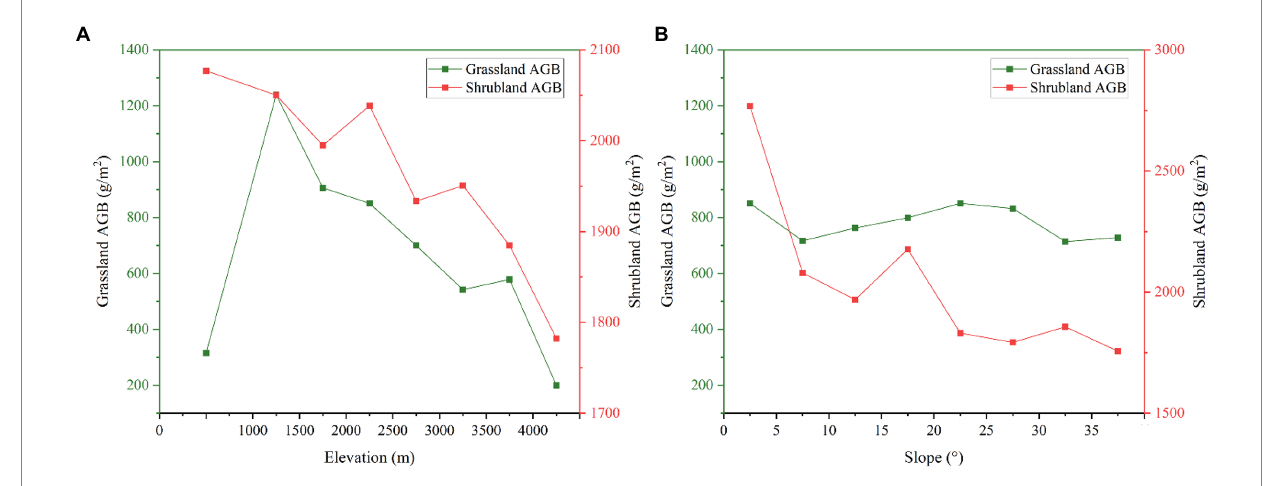
FIGURE 7 The variation of grassland and shrubland AGB along the elevation (A) and slope (B) .